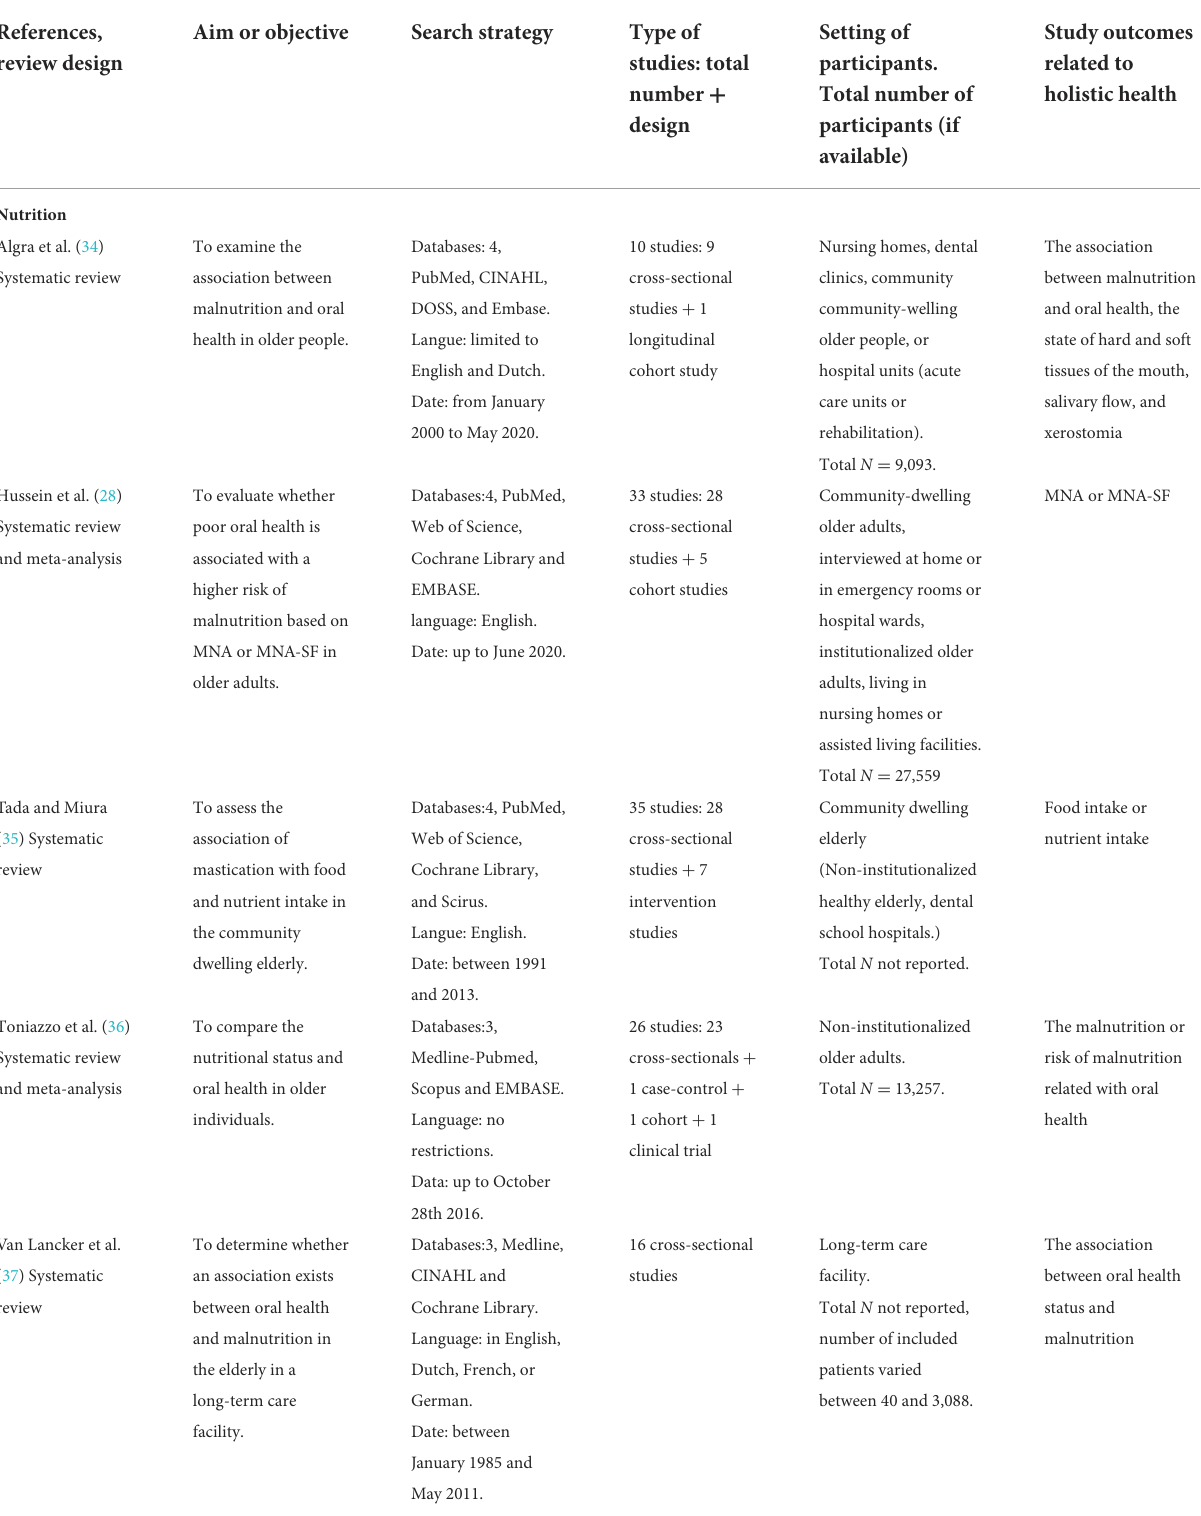
TABLE 2 Main characteristics of the articles included in the systematic umbrella